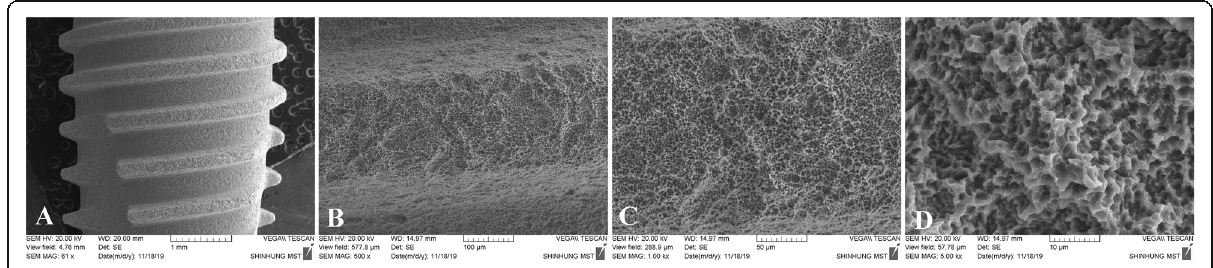
Fig. 2 SEM view of the surface morphology of the tapered, sand-blasted, and acid-etched (S&E) surface. SEM × 60 magnification view ( a ), × 500 magnification view ( b ), × 1000 magnification view ( c ), and × 5000 magnification view ( d )